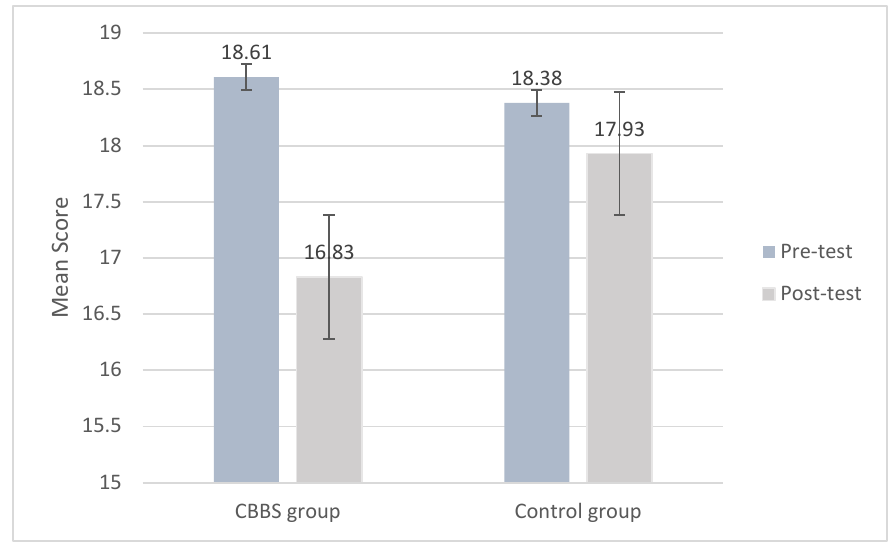
Figure 6. Mean scores of attention span at pre-test and post-test by group. The Linear Mixed Model revealed a significant main effect of time ( F (1, 680.336) = 28.145, p < 0.01) on cardiorespiratory fitness. The ICC of the cardiorespiratory fitness is 0.49. The results indicated that the two groups significantly increased their performance in cardi- orespiratory fitness from baseline to the post-test (Figure 7). There was no significant main effect of the group and interaction effect between time and group ( F (1694.605 ) = 2.508, p > 0.05; F (1680.336) = 0.063, p > 0.05). The ICC of the cardiorespiratory fitness is 0.49. Figure 7. Mean scores of PACER test at the pre-test and post-test by group. 4. Discussion This study was central to examining the effectiveness of the 16-week CBBS interven- tion in improving cognitive function and cardiorespiratory fitness among 4 th -grade stu- dents, compared to the 4th-grade students attending regular PE classes. As was expected, the students who participated in the CBBS intervention showed noticeable improvements in their concentration and attention span from the baseline to the post-test, compared to the students in the comparison group. Consistent with the previous studies, the results indicate that bilateral coordinated movements and motor skills are beneficial to improv- ing concentration performance and attention span in elementary school students [4,7,26 – 28].